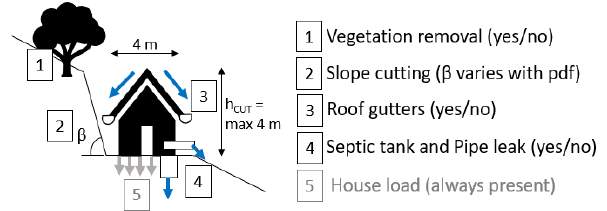
Figure 3. Urban properties of informal housing included in the slope stability analysis. Each house corresponds to a cut on the slope. Cut slope angle varies according to its probability distribu- tion, defined in Table 1. Vegetation, roof gutters, and leaking tanks and pipes are stochastically inserted or not. The house on the cut slope is always present, and its load is not varied. The height of the cut slope varies relative to the cut slope angle, but it is forced to be maximum